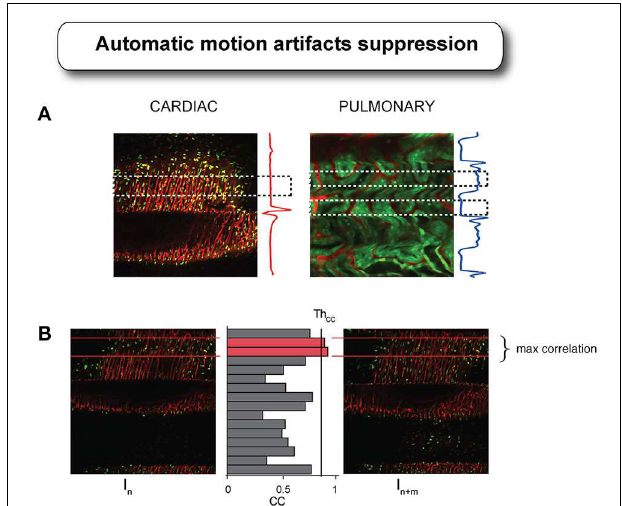
FIGURE 10 | Cardiac and respiratory motion artifacts present in the heart and in the kidney during laser scanning microscopy acquisition with their corresponding ECG and ventilator pressure traces. (A) Dashed boxes indicate the temporal areas where no motion is present or minimal within the acquired images. (B) If reproducibility is present in certain part of the motion, as guaranteed by the presence of the tissue stabilizer, then images acquired at different time points will present “locally” different values of correlation. By combining all the segments with high values of correlation coefficient, it is possible to reconstruct a final motion artifact-free image. Adapted from Lee et al.